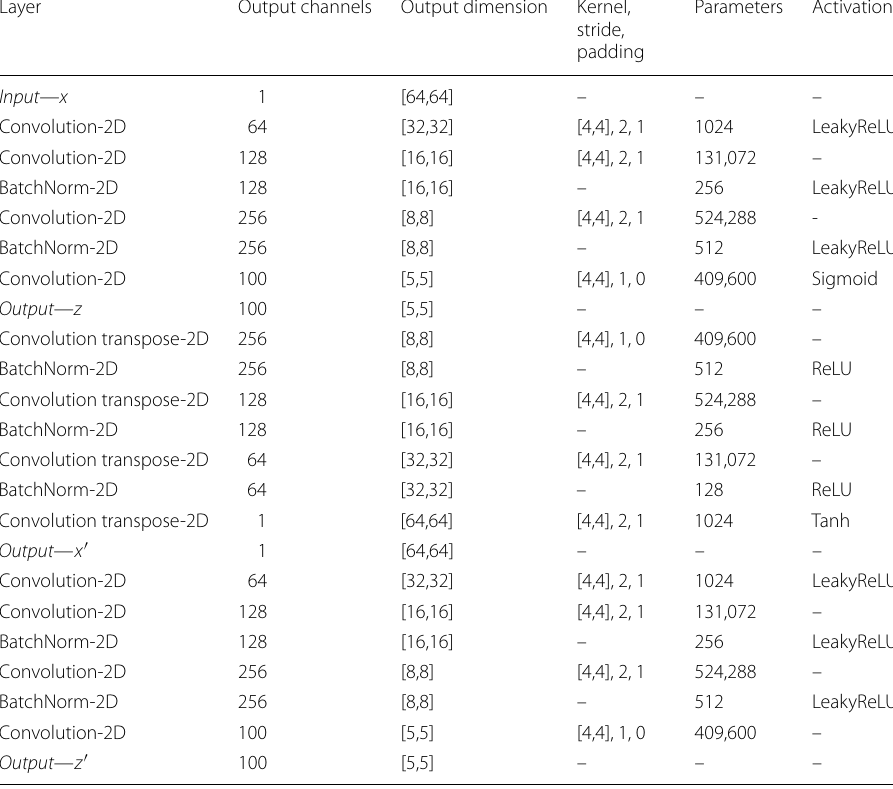
Table 1 The network architectures of NetG